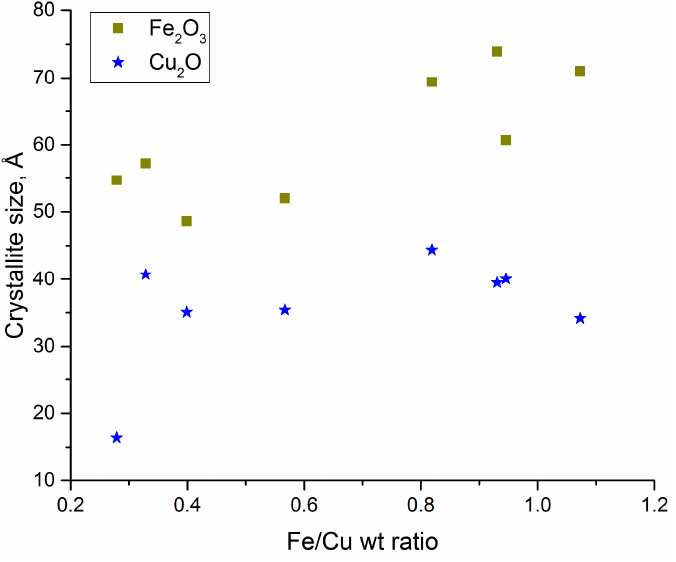
Figure 7. Effects of the pairing metals ratio on crystallite size.